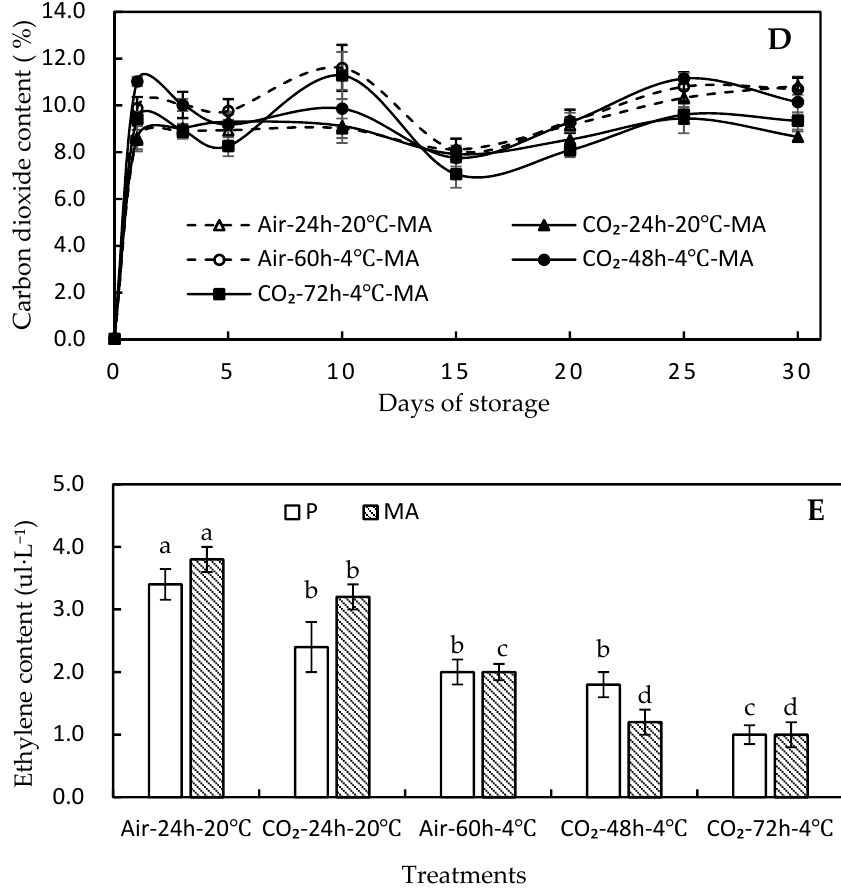
Figure 1. Changes in oxygen ( A , B ), carbon dioxide ( C , D ), and ethylene ( E ) contents in perforated (P) and modified atmosphere (MA) packages. ( A , C ): Perforated packages; ( B , D ): 10,000 cc/m 2 ∙ day ∙ atm oxygen transmission rate (OTR)-modified atmosphere packages (MA). Treatments were 60% CO 2 or air for 24 h at 20 °C, 60% CO 2 for 48 or 72 h, or air for 60 h at 4 °C. All the groups were packaged and stored at 4 °C until the final day. Values are presented as means ± SE ( n = 5). Different letters among the same packaging types indicate a statistical difference using an LSD (Least Significant Difference) test at p < 0.05.